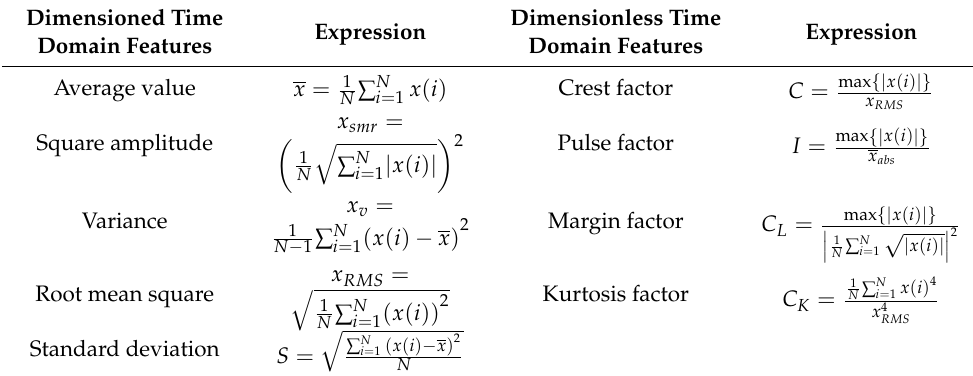
Table 2. Expression of time domain features.